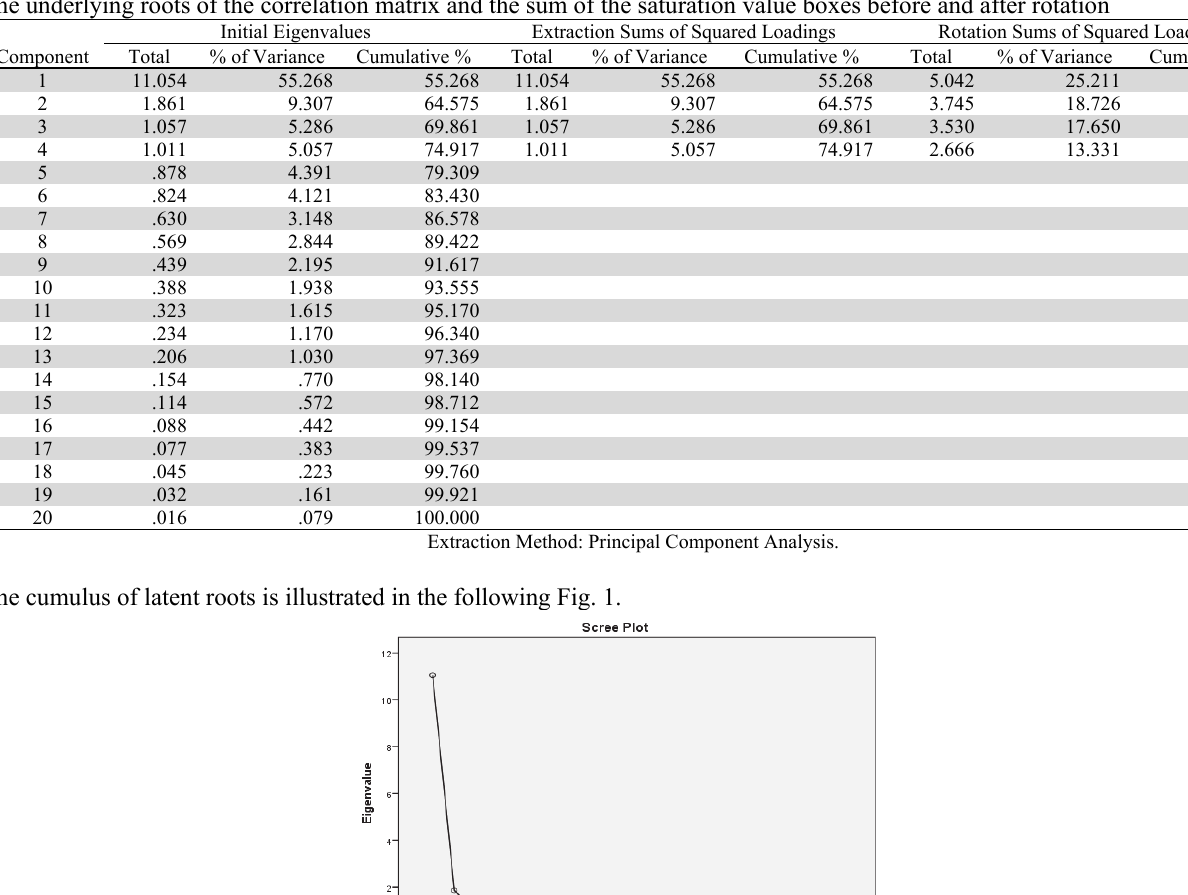
Initial Eigenvalues Extraction Sums of Squared Loadings Component